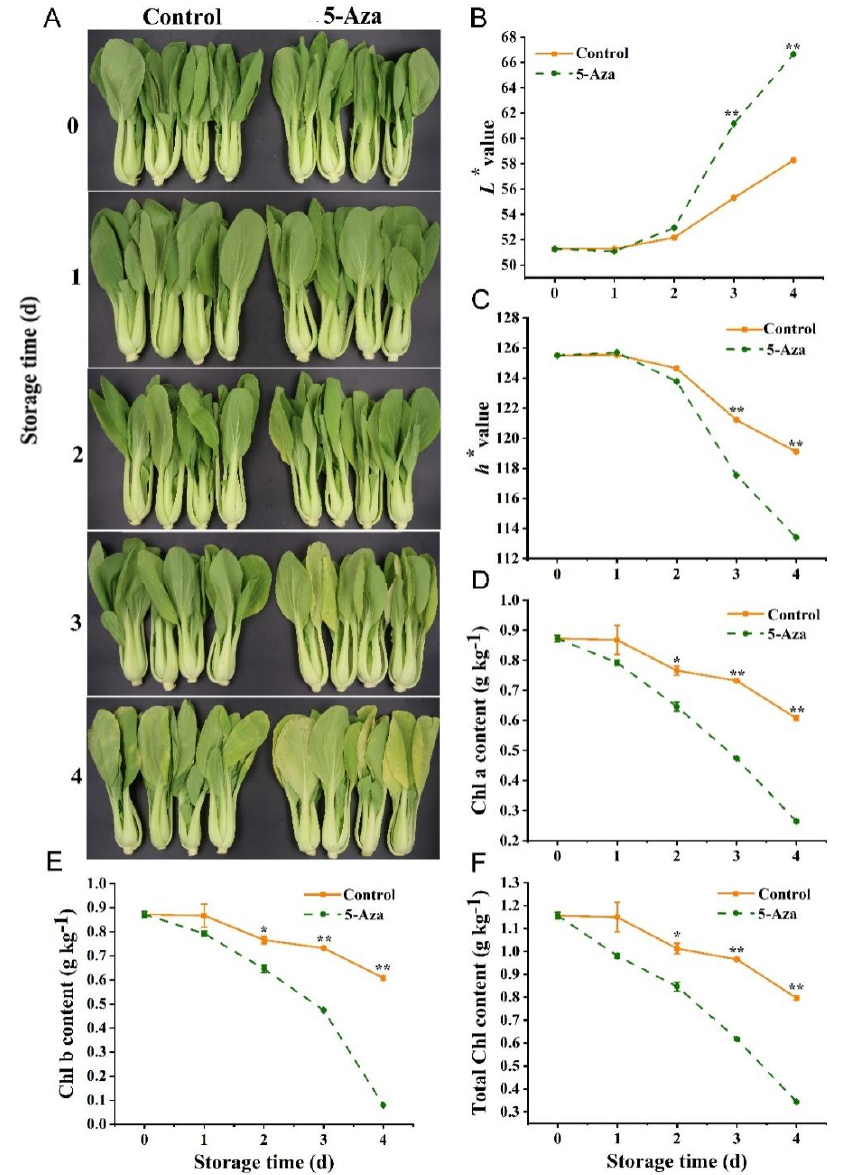
Figure 3. Phenotype ( A ), L* value ( B ), h* value ( C ), Chl a ( D ), Chl b ( E ) and the total Chl ( F ) of pak choi in the treatment and control groups at 20 ± 1 °C. The data in the figure are the mean ± SD of three biological replicates. The asterisks in the figure indicate significant differences between the mean values of treatments and controls (* p < 0.05; ** p < 0.01).